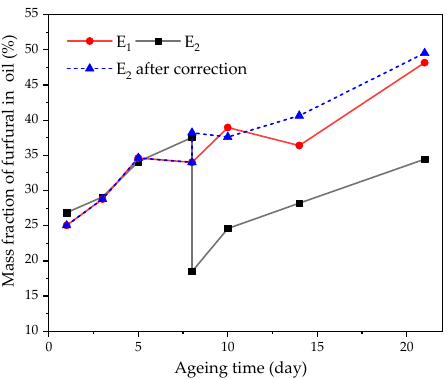
Figure 17. The relationship between furfural mass fraction and aging time after oil replacement.